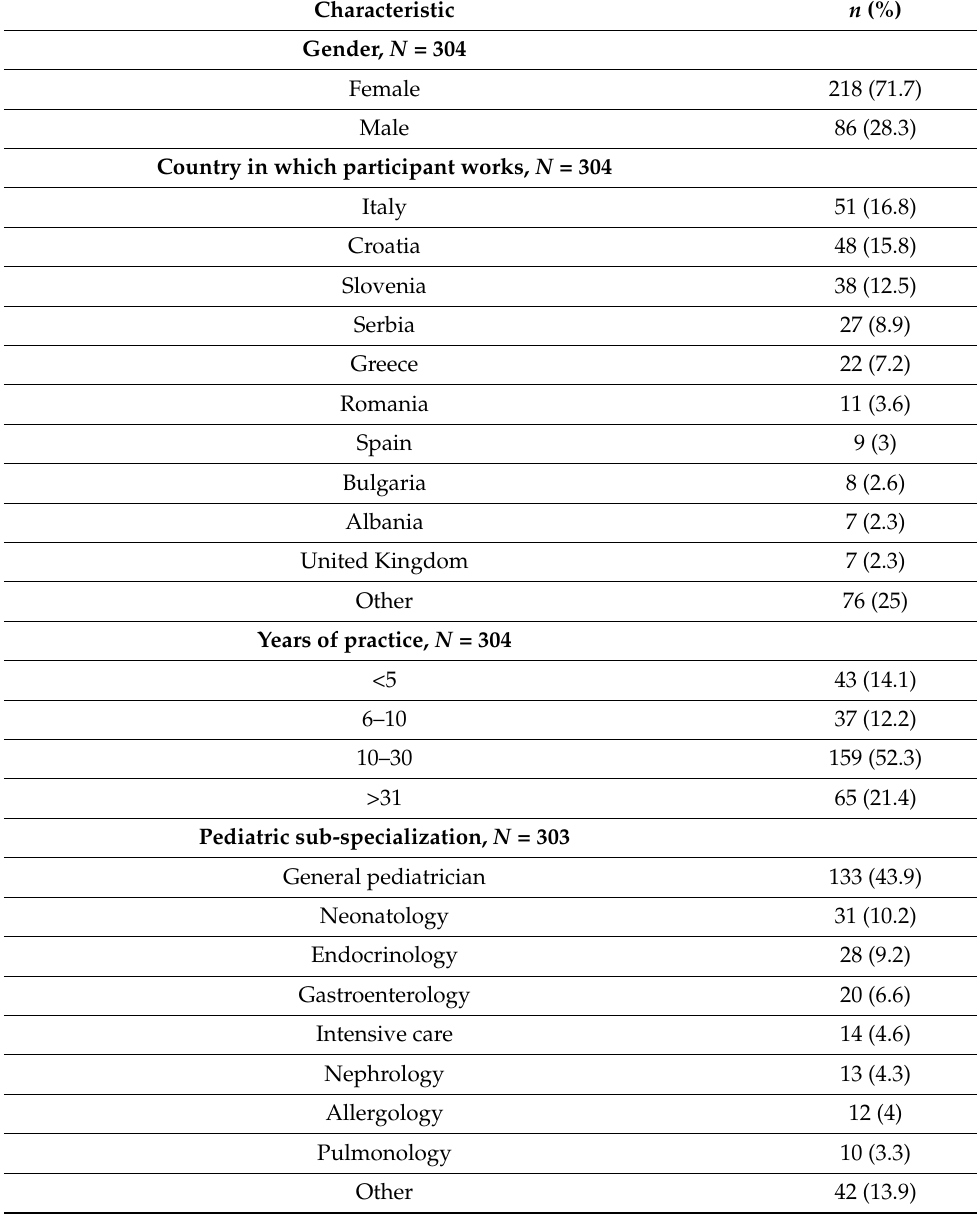
Table 1. Study participants